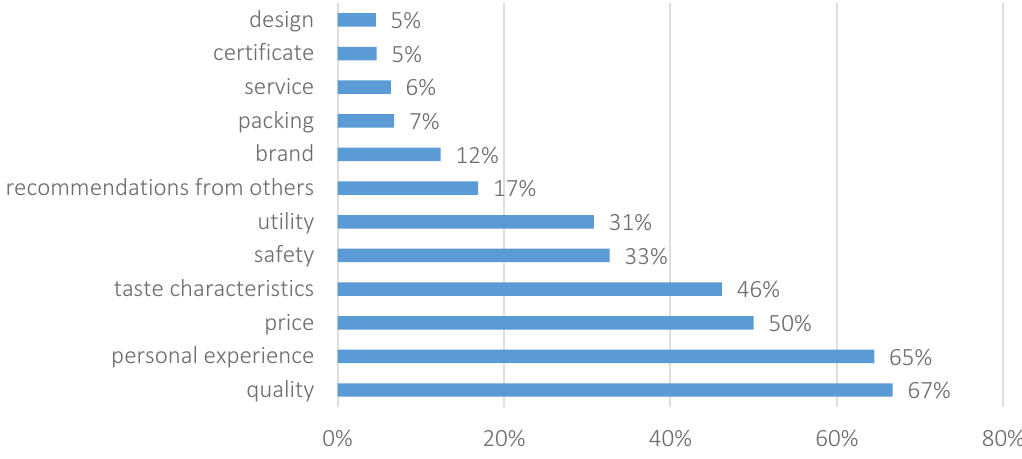
Figure 2. Responses to the question: Which of the following factors determines your choice when purchasing agri-food products? Choose maximum three